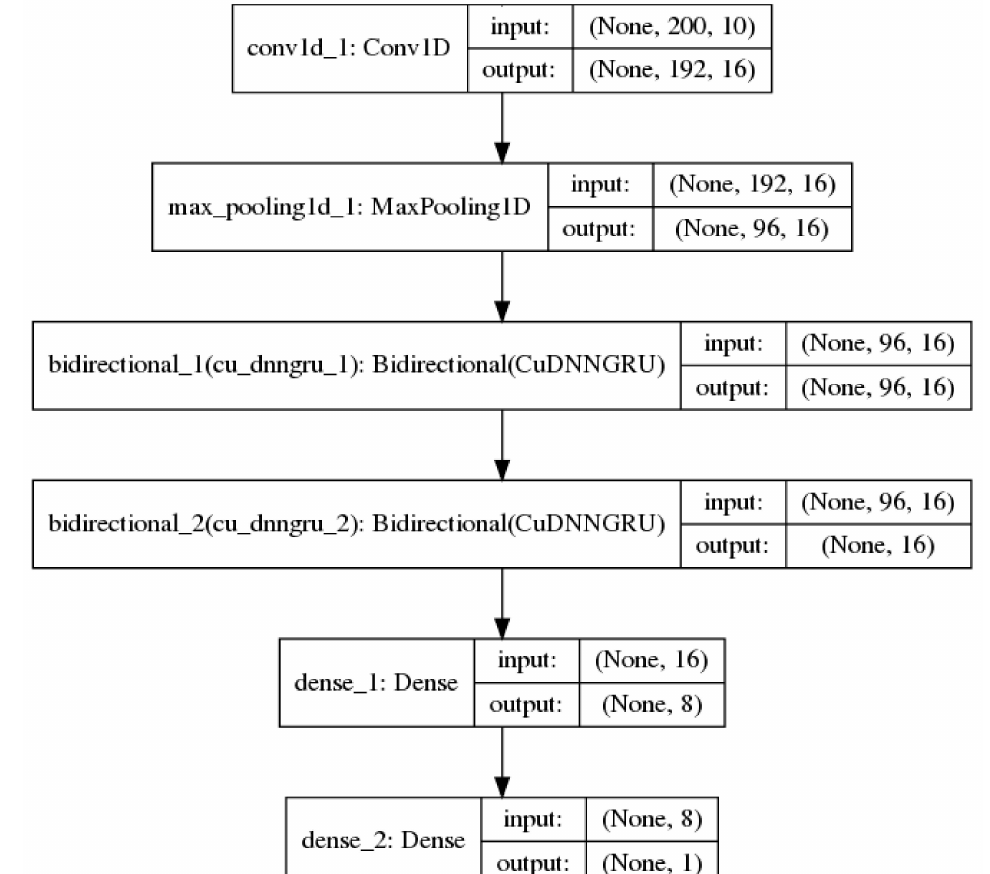
Figure 1. A neural network model with 1 convolution 1D and 1 max pooling layer before bi-directional recurrent and fully-connected